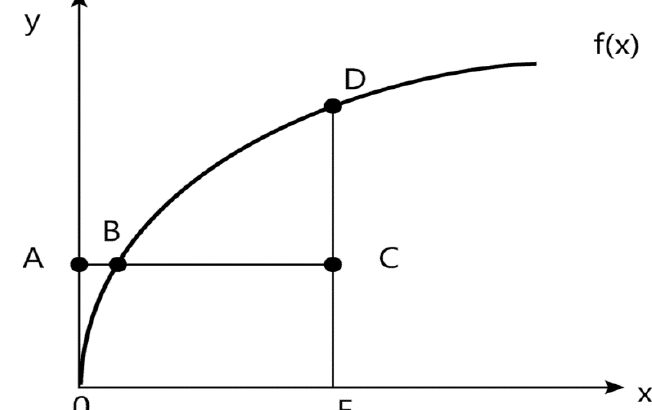
Figure 1 - Representation of the Efficiency Border resulting from the use of the